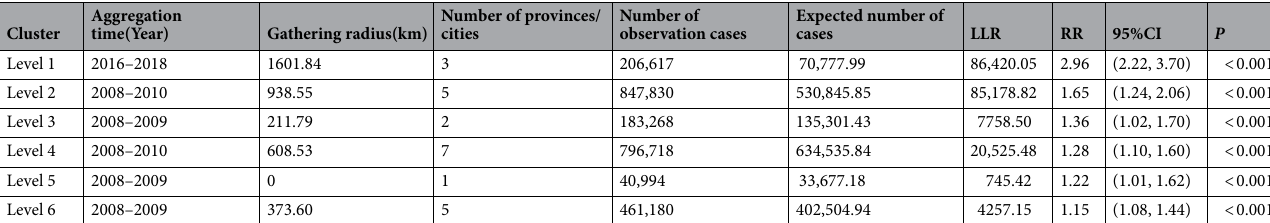
Table 2. Space time scanning analysis of reported cases of pulmonary tuberculosis in China from 2008 to